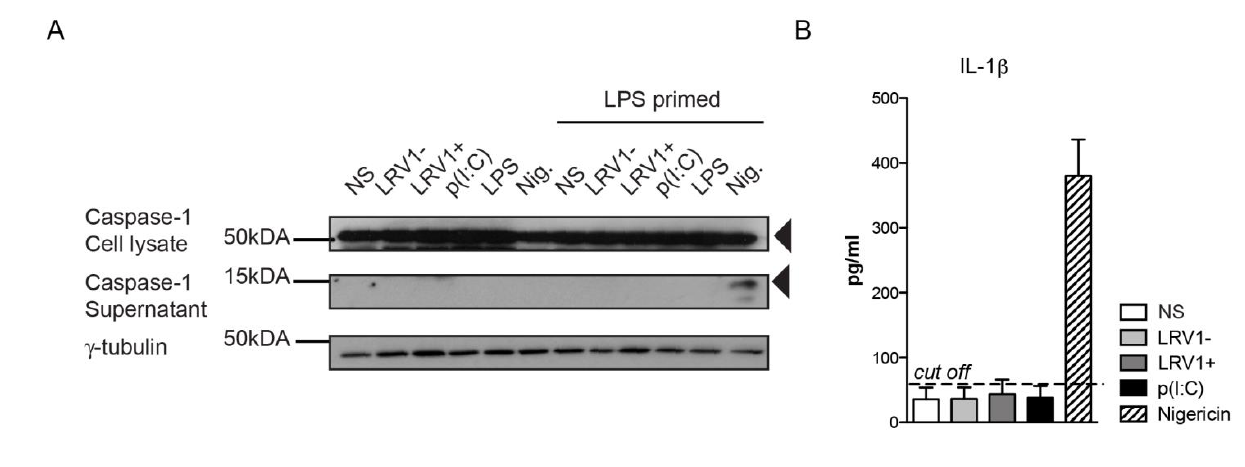
FIGURE 3: L. guyanensis does not activate the inflammasome in macrophages, irrespective of its LRV1 status. (A-B) BMDMs from C57BL/6 WT mice were primed with 200 ng/ml of LPS for 3 hours. Subsequently, cells were incubated with LgyLRV1+ or LgyLRV1- parasites, poly(I:C) or culture medium. Additionally, a 1 hour treatment with 5 µM of Nigericin was used as a positive control for the inflammasome activation. Proteins were extracted from cell lysates (CL) and supernatants (SN). (A) Cell lysates were blotted for caspase-1. (B) IL-1β detected by ELISA in cell-free supernatant. Graphs are representative of a minimum of three independent experiments, using four technical and two biological replicates, and showed as mean ± SEM. Non-parametric Student’s t-test was used to calculate